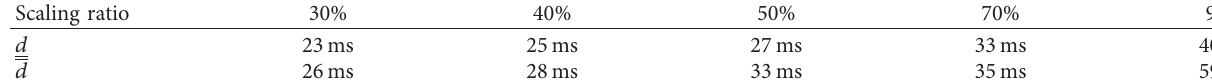
Table 4: The lower and upper bounds of the total system delay.